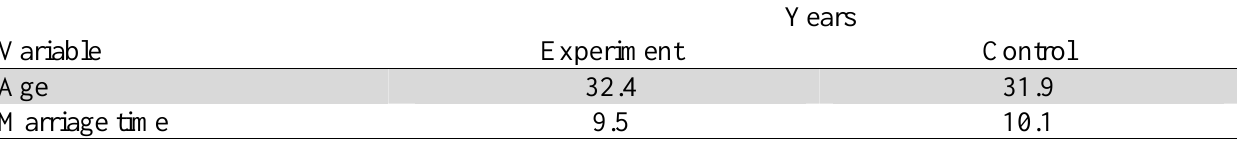
The results of some basic statistics